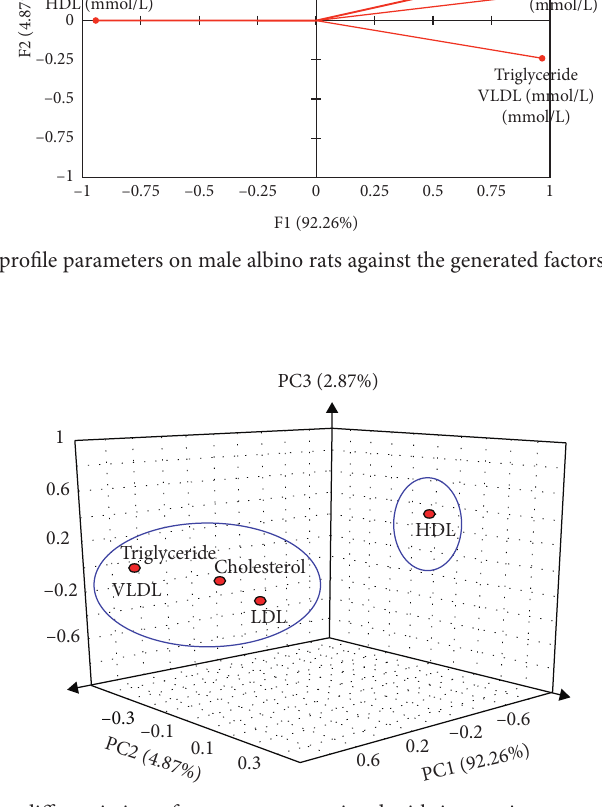
Figure 5: Score plot illustrating the differentiation of parameters associated with interactions among lipid profile parameters. A three- component system explaining 100% of total variance was observed after statistical PC analysis. Table 4: Concentration of heavy metals (mg/kg) on blood of male albino rats treated with metal mixture. Treatment Cadmium (Cd) Deionized H 2 O